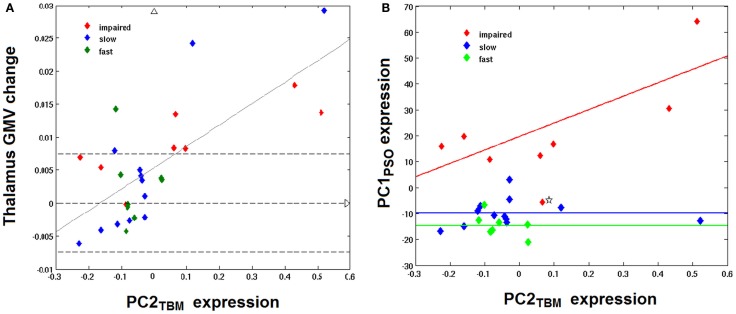
Correlation between PC2TBM, thalamic GMV change, and longitudinal hand function recovery. (A) shows the relationship between thalamic gray matter volume (GMV) change and expression of the structural covariance network PC2TBM: thalamus GMV change = 0.0325 × PC2TBM + 0.0053; R = 0.72, p < 0.001. Dashed transversal lines indicate the interval of reliable GMV change (± 0.75%), as determined in previous studies. (B) shows the correlation between expression of the structural covariance network PC2TBM and the first component of longitudinal behavioral recovery of skilled hand function, PC1PSO. Only impaired patients show a strong correlation between network expression and hand function recovery; PC1PSO = 51.9 × PC2TBM + 19.76; adjusted R = 0.74, p < 0.05. The recovered subgroups are characterized by a constant of differing magnitude. One patient with negative expression coefficients of PC1PSO (marked by an asterisk) has been identified as outlier (see text).